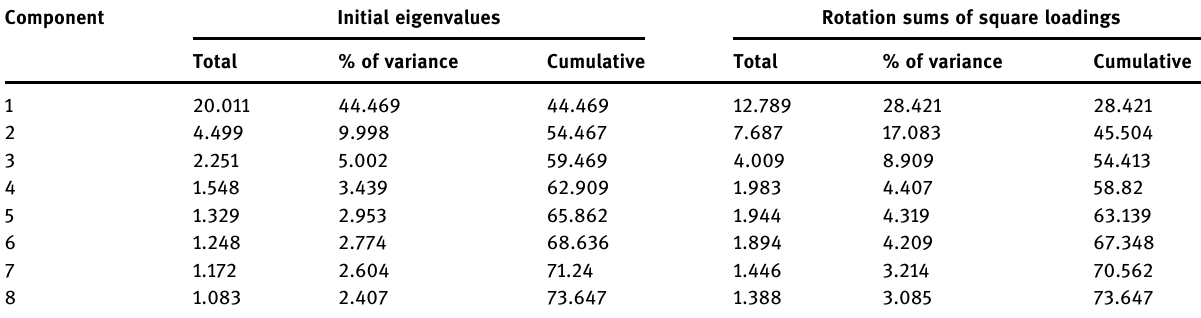
Table 7: Findings of overall variance illustrated for factors of project delay Component Initial eigenvalues